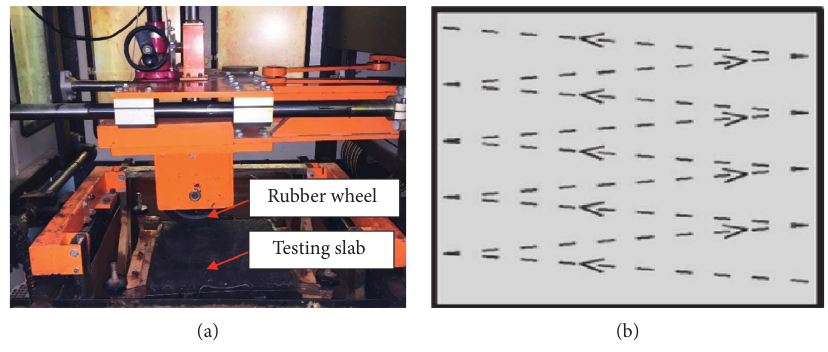
Figure 3: Rubbing test: (a) test equipment; (b) wheel moving track.